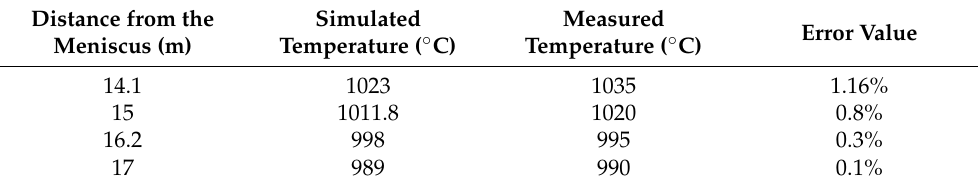
Figure 4. Variation tendency diagram of center and surface temperature of bloom with distance to the meniscus. the meniscus. Table 3. The comparison of the simulated and measured surface temperatures. Table 3. The comparison of the simulated and measured surface